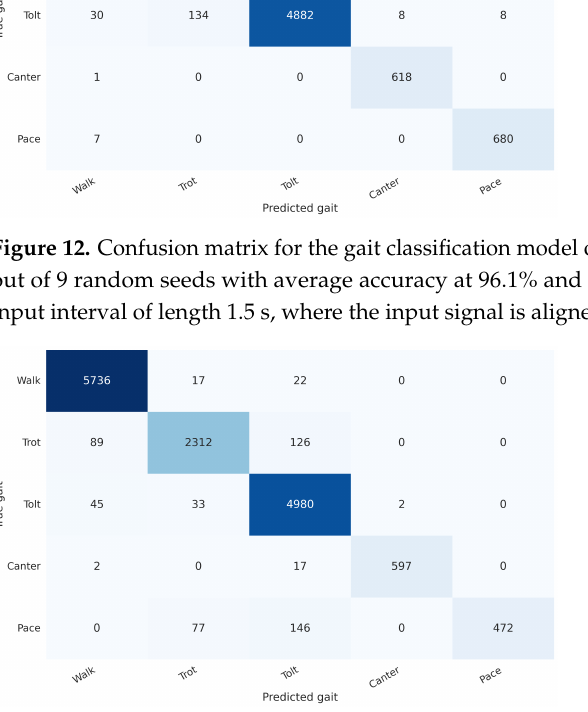
Figure 13. Confusion matrix for the gait classification model on the test set with 96.1% accuracy (best out of 9 random seeds with average accuracy at 93.9% and median accuracy at 92.7%). We use an input interval of length 1.5 s, where the input signal is aligned to the